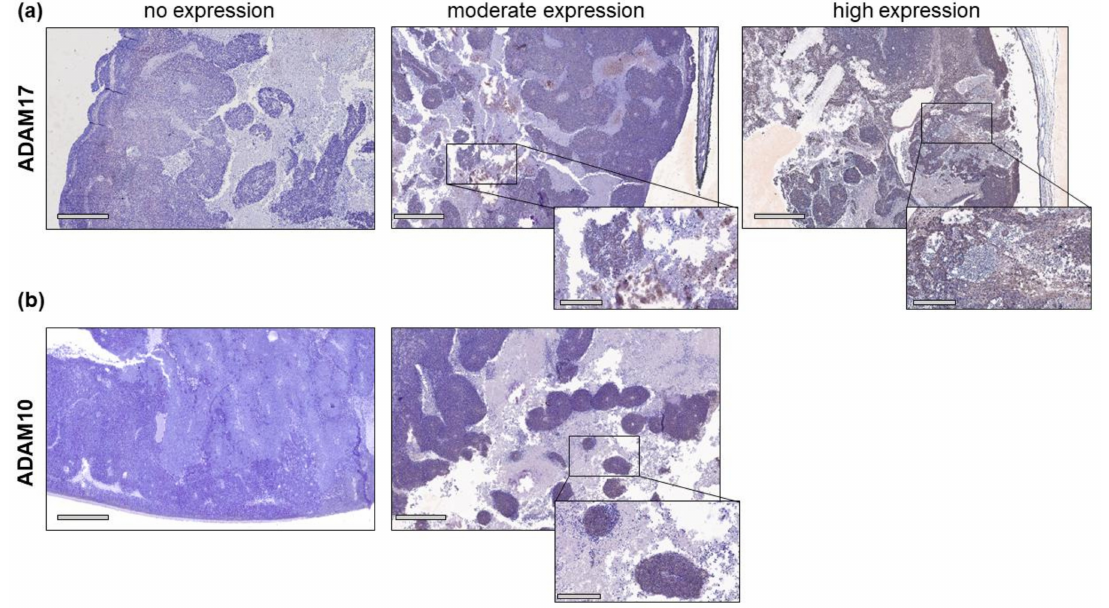
Figure 1. Histological analysis of primary RB tumors. ADAM17 ( a ) and ADAM10 ( b ) expression in exemplary paraffin sections of human RB patient tumors. Immunohistochemistry was detected by diaminobenzidine (brown signal) and hematoxylin counterstaining (blue nuclei staining). Scale bars, 600 µ M and 200 µ M (magnified